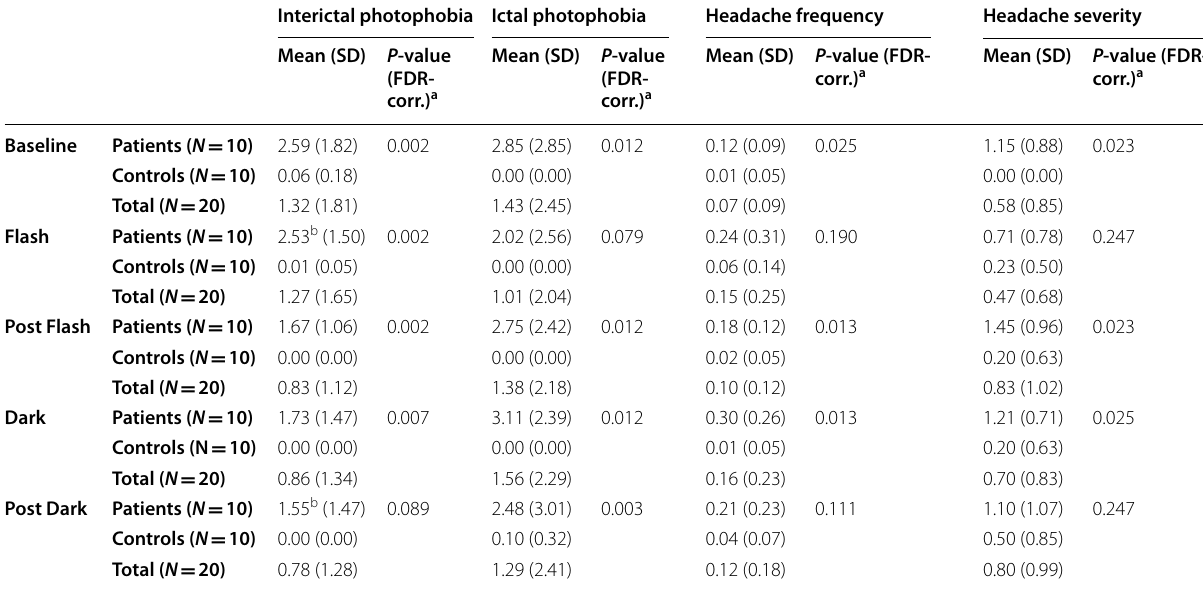
a Group comparisons using Quade analysis of covariance (adjusted for multiple comparisons using false discovery rate (FDR)) b Significant post-hoc comparisons between study phases